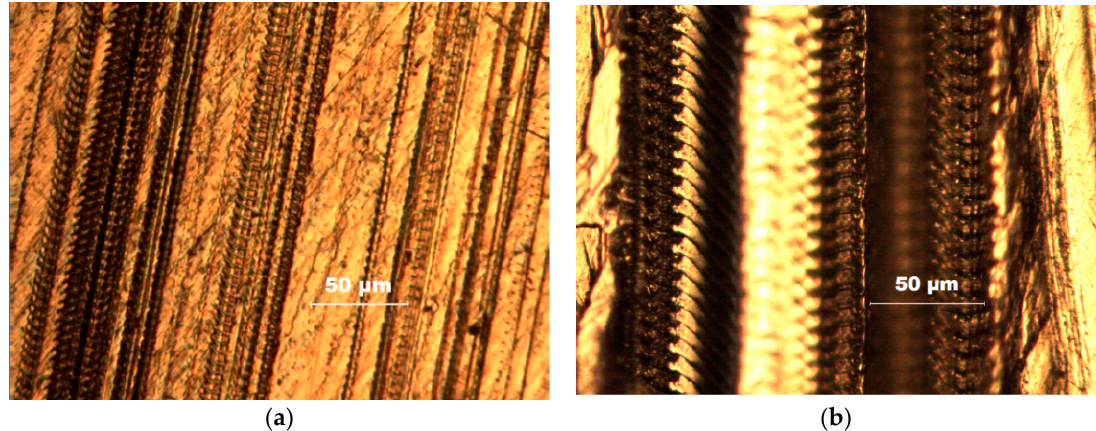
Figure 42. Workpiece surface topography. ( a ) Experiment No. 1; ( b ) Experiment No. 2.